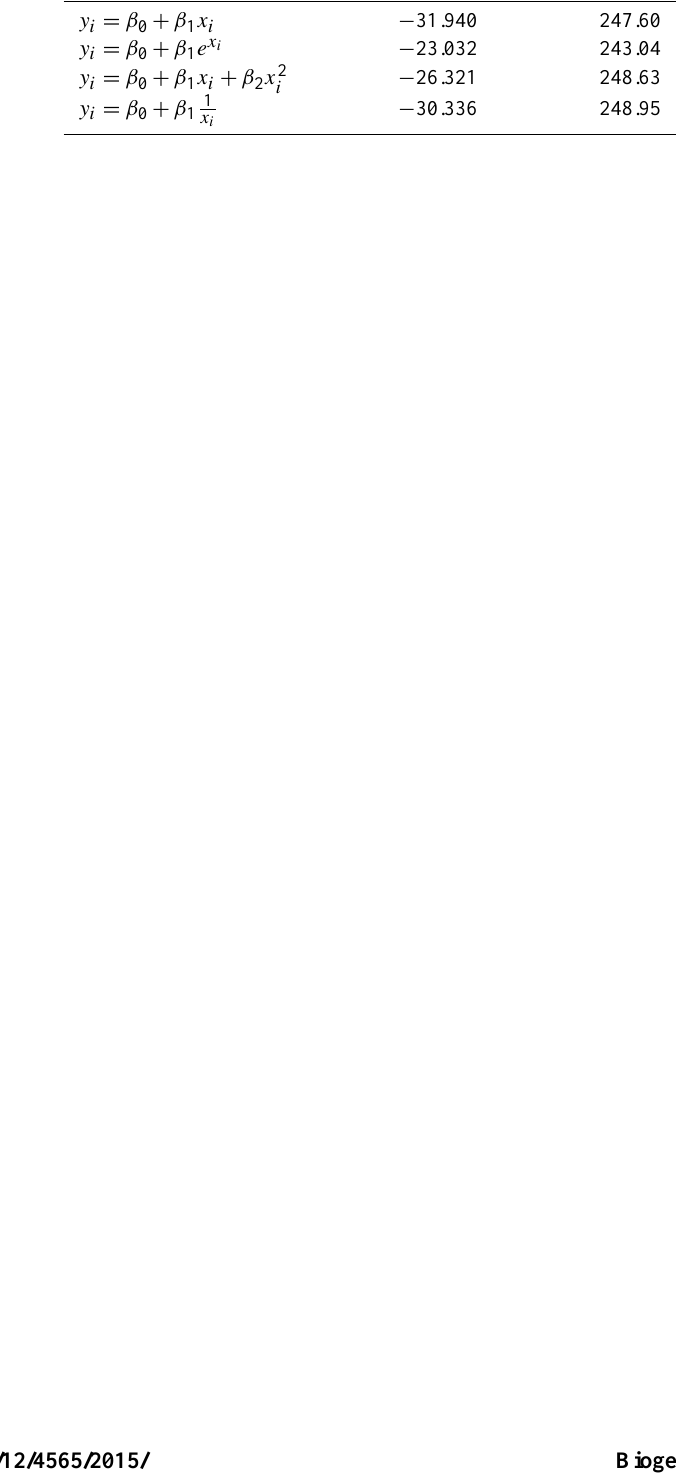
Table A1. AICc (corrected Akaike information criterion) of the different regression models for PO 3 −